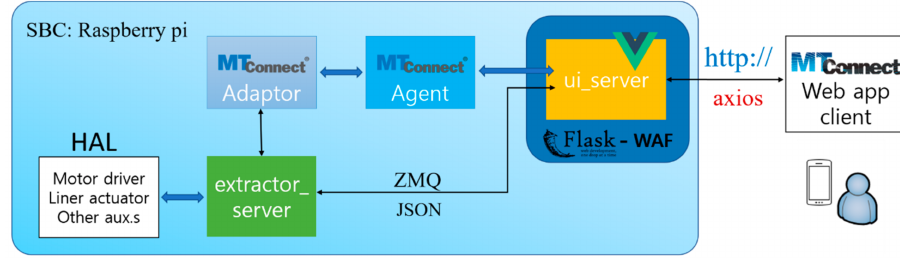
Figure 7. MTConnect data